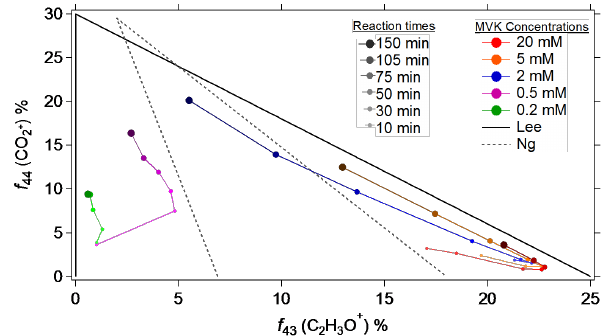
Figure 8. Fractions f44 versus f43 for the nebulized solutions from experiments A, B, C, D and E, as measured by the HR-ToF-AMS are compared to ambient air LV-OOA and SV-OOA from the com- pilation by Ng et al. (2010) (dashed black triangle), and are also compared to the nebulization data by Lee et al. (2011a) (dotted grey triangle). For our experiments, the signal from blank experiments was subtracted. The data are shown for experiments A, B, and C from 10 to 150min of reaction, and for experiments D and E from 15 to 150min of reaction. The gas–particle partitioning in our set-up may alter the relative oxygenation of the OA produced, especially at low initial